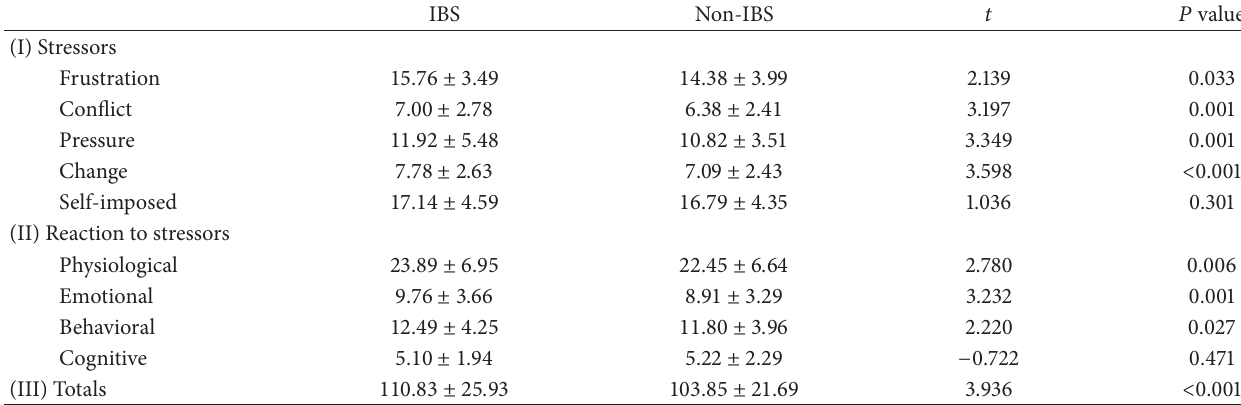
Table 5: The SLSI scores between IBS and non-IBS.